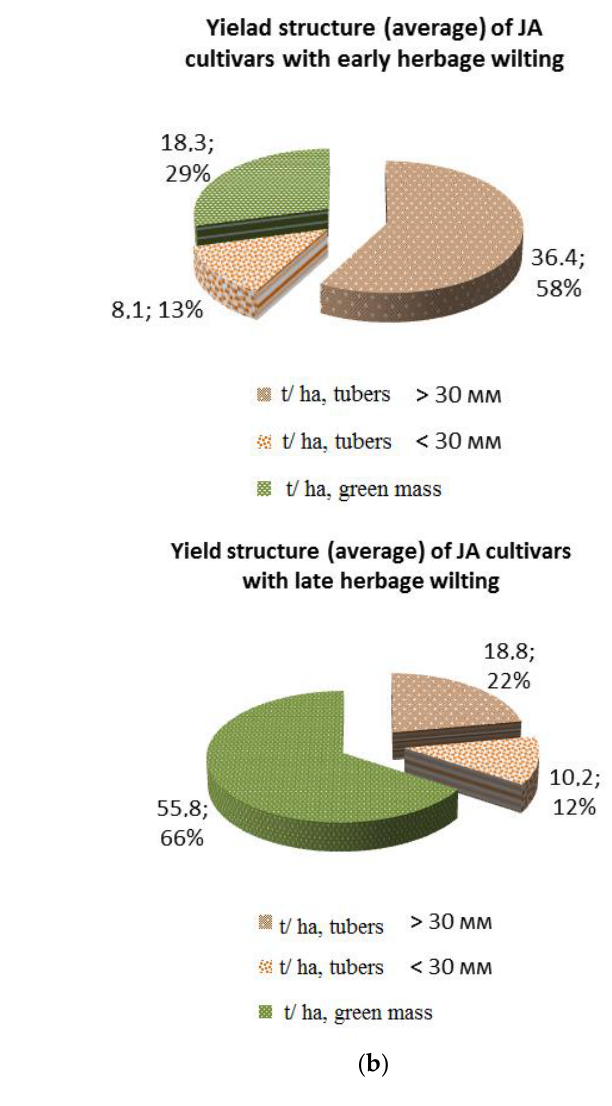
Figure 8. Structure of JA yield (tubers and green mass) according to groups of herbage wilting time: ( a ) harvesting in the 1st ten-day period, ( b ) harvesting in the 3rd ten-day period of October and September.